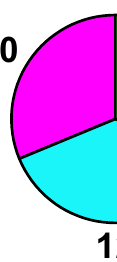
Figure 2. A diagram of the investigated groups of subjects. The left-hand tremor PD patients are indicated by the magenta color; the right-hand tremor PD patients are indicated by the cyan color; the healthy volunteers are indicated by the green